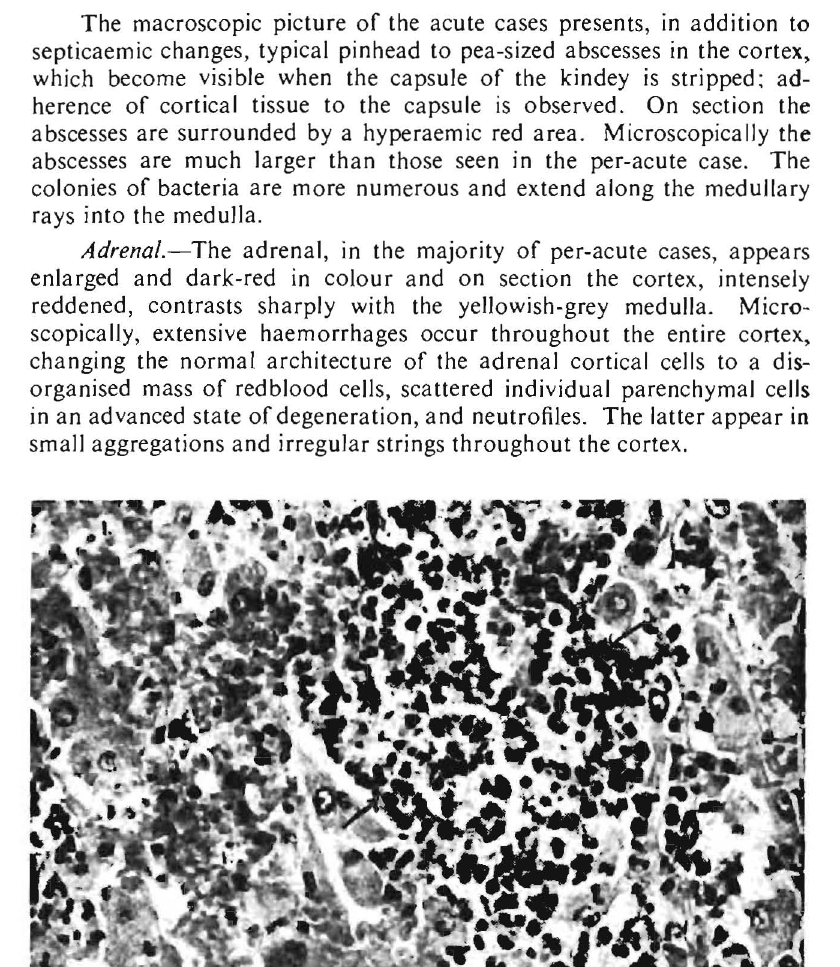
Fig. 3. Adrenal cortex with micro-abscess (arrows) and haemorrhage (I) in an acute case. Hand E staining. X 480. In the acute subject the adrenal may also appear haemorrhagic and minute abscesses are seen as pin-point dull-grey